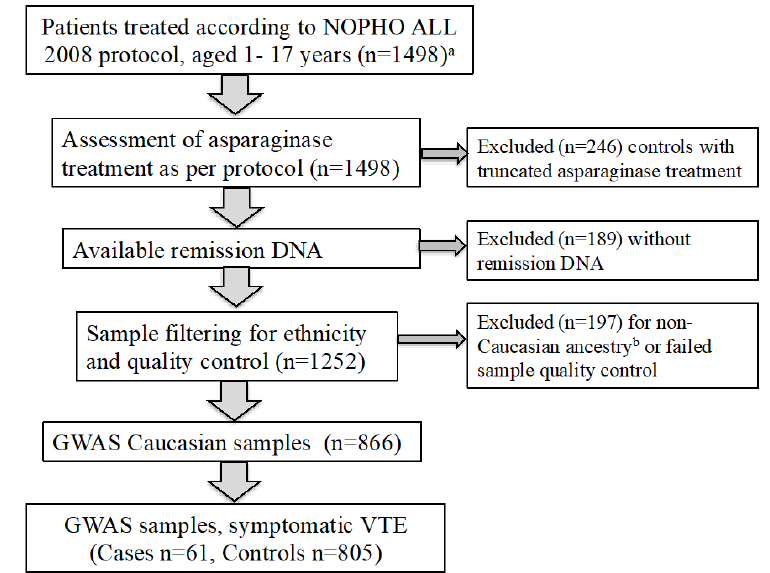
Figure 1. Consort diagram of 866 individuals in the Nordic Society of Pediatric Hematology and Oncology (NOPHO) genome-wide association study (GWAS) discovery cohort for symptomatic venous thromboembolism (VTE). a NOPHO clinical cohort as described in Rank, et al., 2018 and Tuckuviene, et al., 2016. In addition, there were three individuals who experienced VTE but who did not fulfil all inclusion criteria for the protocol (two mixed-phenotype acute leukemia (MPAL), one pre-treatment). b Caucasian ethnicity defined by CEU, (Utah Residents (CEPH) with Northern and Western European Ancestry) clustering in principal component analysis (see methods). The final NOPHO GWAS cohort for symptomatic VTE comprised 61 cases (those who experienced symptomatic VTE during first-line ALL treatment) and 805 controls (those who did not experience symptomatic VTE during first-line ALL